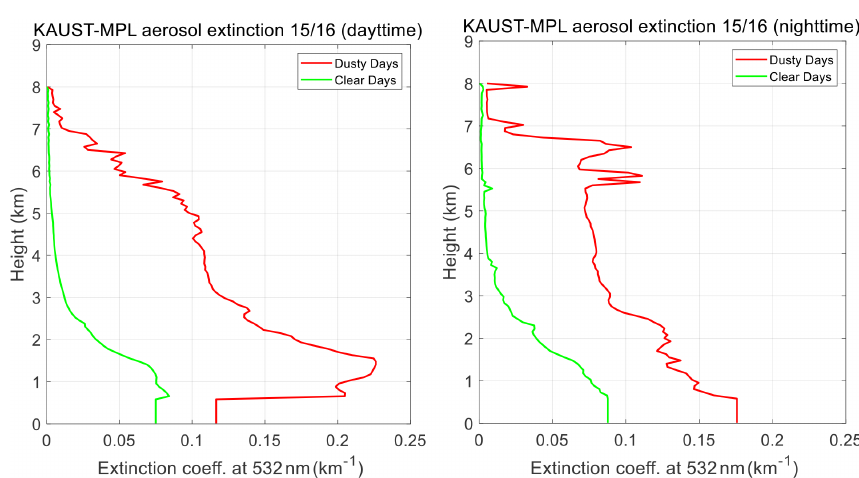
Figure 12. Average vertical profiles of aerosol extinction corresponding to “clear days” and “dusty days” from KAUST–MPL data.